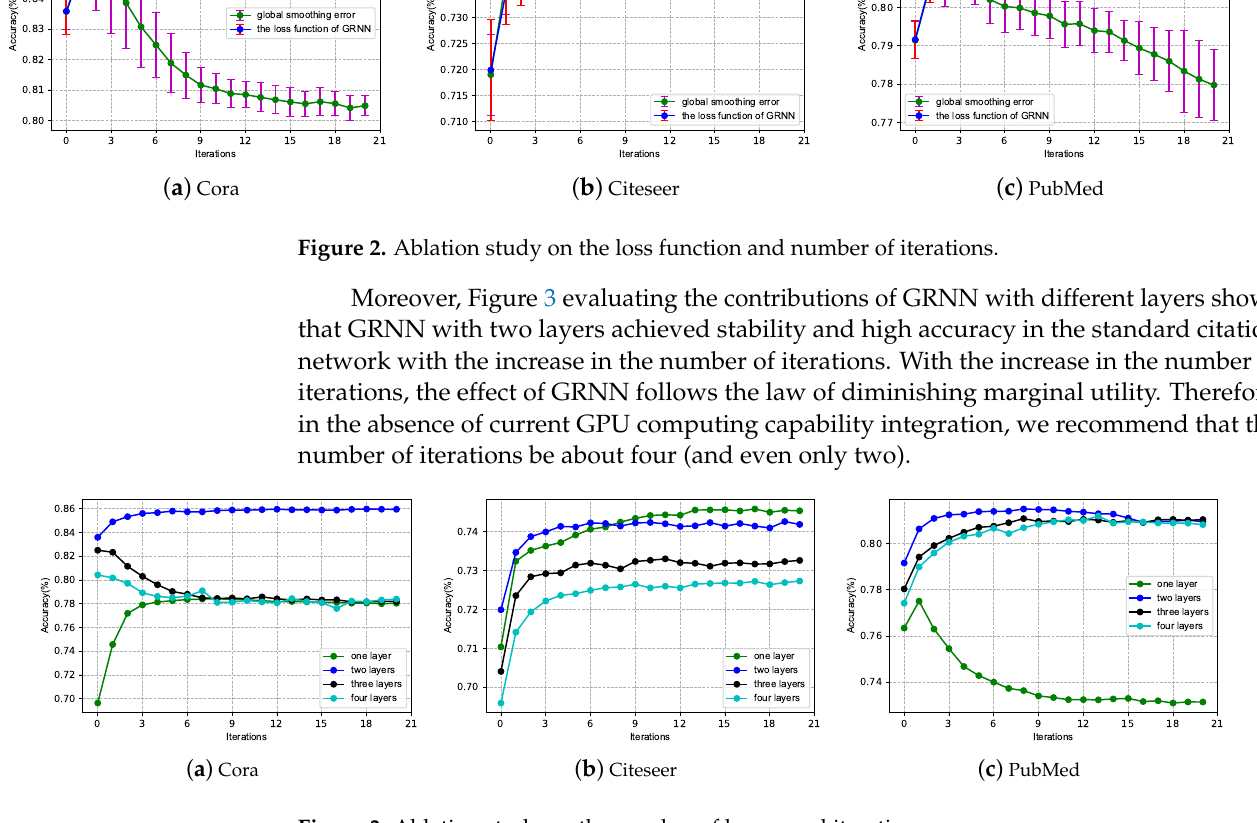
Figure 3. Ablation study on the number of layers and